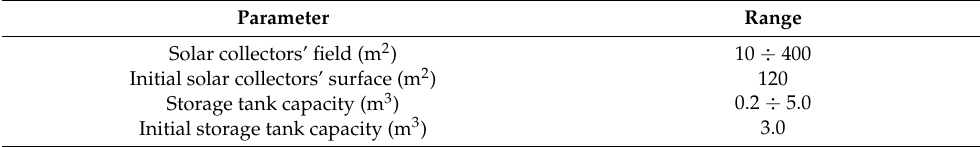
Table 10. Genetic algorithm optimization variable boundaries and initial